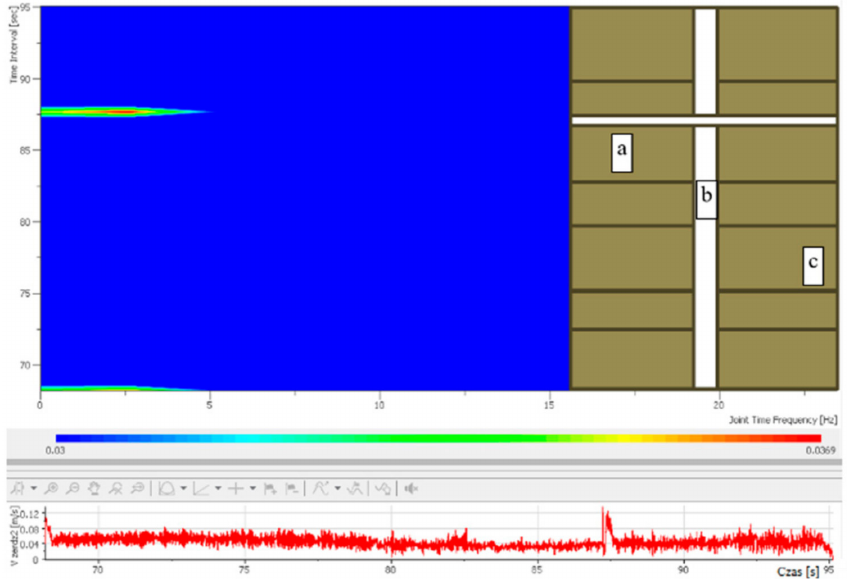
Figure 22. The detected signal on the recorded spectrogram corresponding to the location the critical discontinuity for borehole 7, rod 1—Hanning window, time domain sieve line set to 50, amplitude level display> 0.03; a, rock layer; b, borehole; c, discontinuity.